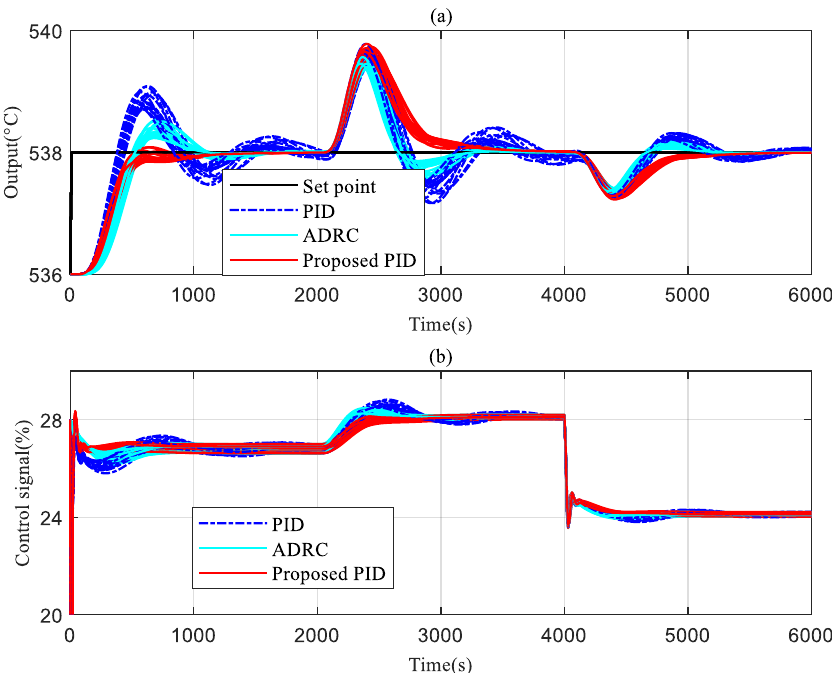
Figure 13. Control performance under an operating condition of 50% load with uncertainty in the SST system ( a ): outputs, ( b ): control signals.